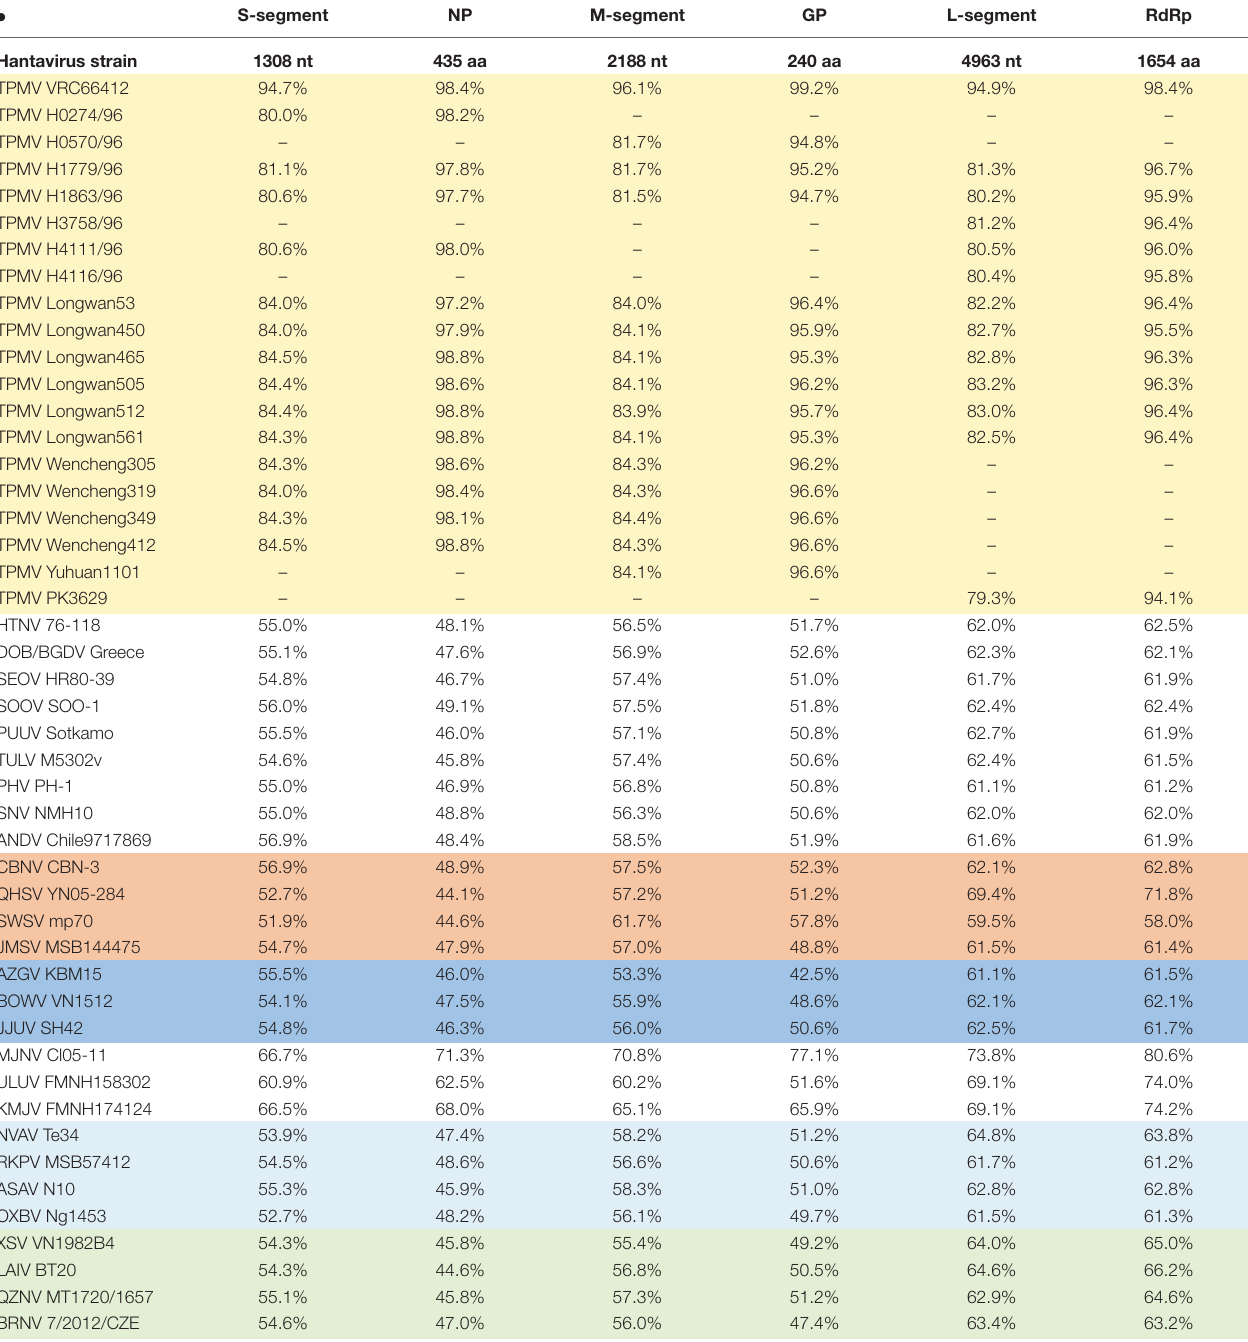
TABLE 2 | Nucleotide and amino acid sequence similarity (%) between TPMV strain H2763 and other TPMV strains, as well as representative rodent-, shrew-, and bat-borne